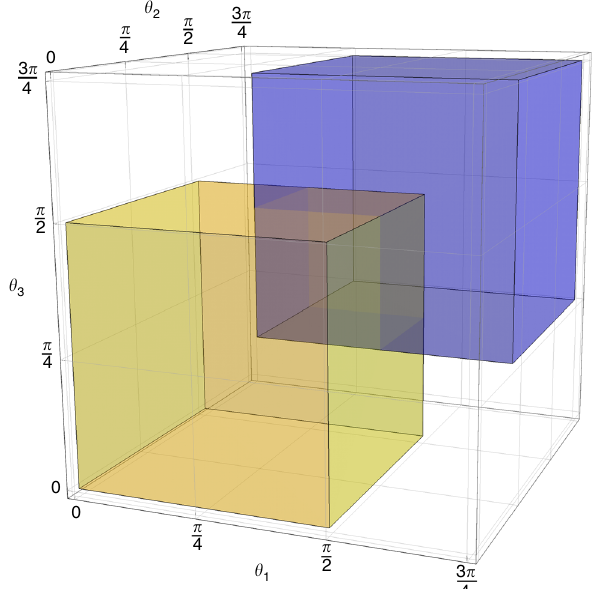
Fig. 2 Orthogonal rotations that can cure the clause Hamiltonians introduced in Eq. (2). The yellow region depicts the angles of rotations that can cure H ð 111 Þ and the blue region depicts the angles of the curing rotations 123 for H ð 000 Þ